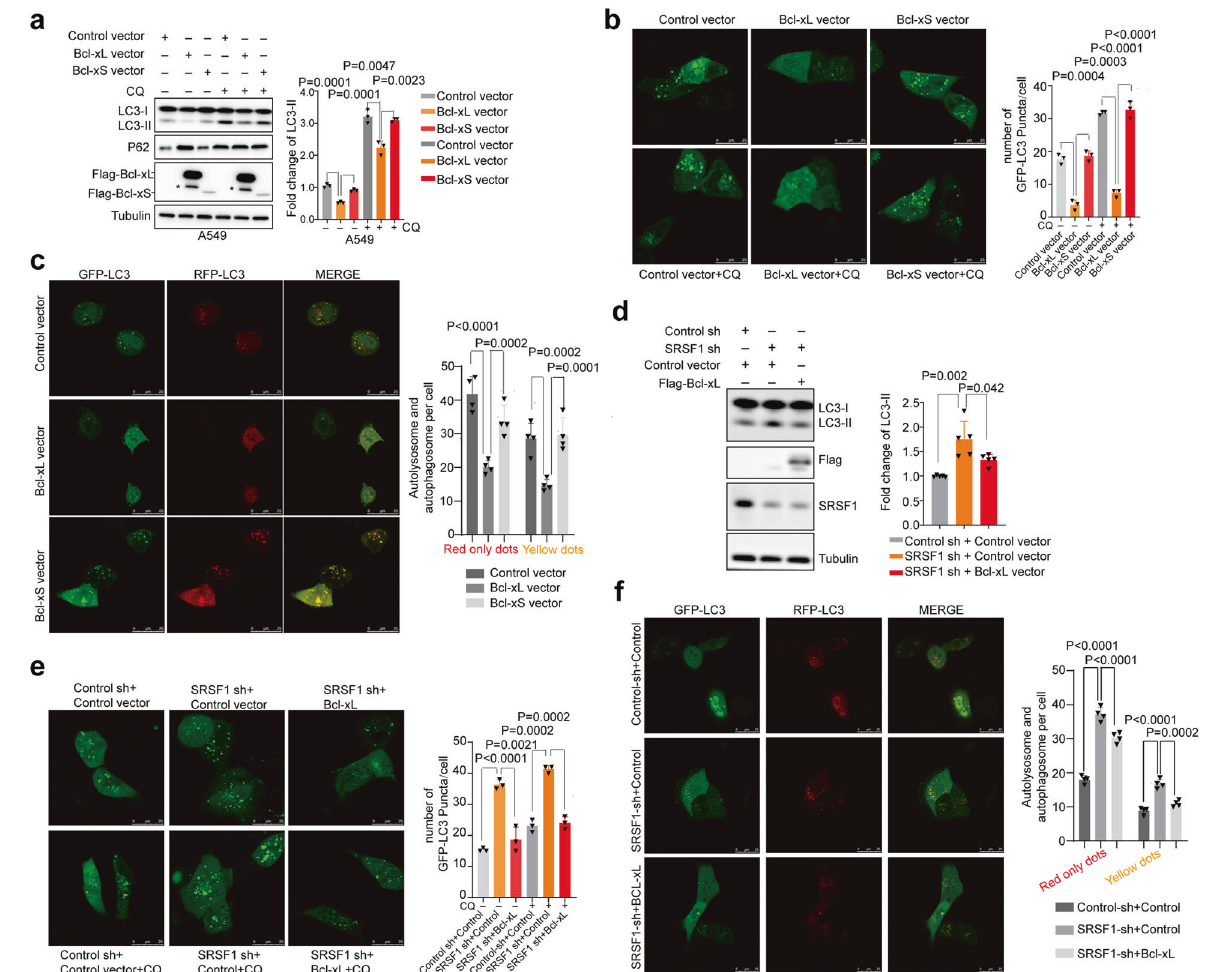
Fig. 3 Bcl-x isoforms differentially regulate autophagy. a The protein levels of LC3 and p62 were determined in A549 cells with stable overexpression of Flag-Bcl-xL, Flag-Bcl-xS, or control vector. The resulting cells were treated without or with CQ (40 µM for 2 h) respectively. The densities of signals were measured by densitometry and three experiments were performed with mean ± SD of relative fold change of LC3-II plotted. Asterisk indicated nonspeci fi c bands. b A549 cells with stable overexpression of Bcl-xL, Bcl-xS, or control vector were transfected with GFP-LC3 respectively. Twenty-four hours after transfection, cells were treated with or without CQ. Three experiments were carried out and the number of GFP-LC3 puncta per cell are represented with mean ± SD. c A549 cells with stably overexpressed Bcl-xL, Bcl-xS, or control vector were transfected with GFP-mRFP-LC3 to examine the expression of GFP and RFP by confocal microscope. Four experiments were carried out with mean ± SD of the number of autophagosomes (yellow dots) and autolysosomes (red-only dots) per cell plotted. d A549 cells with stable decrease of SRSF1 or control were transiently transfected with Flag-Bcl-xL or control vector. The protein levels of LC3 and SRSF1 were examined in a western blot assay. The densities of signals were analyzed by densitometry and fi ve experiments were carried out with mean ± SD of relative fold change of LC3-II plotted. e A549 cells with stable decrease of SRSF1 or control were transiently transfected with Flag-Bcl-xL or control vector and GFP-LC3. Twenty-four hours after transfection, cells were treated with or without CQ. Three experiments were performed and the number of GFP-LC3 puncta per cell are represented with mean ± SD. f A549 cells with stable reduction of SRSF1 or control were transiently transfected with Flag-Bcl-xL or control vector and GFP-mRFP-LC3 to examine the expression of GFP and RFP by confocal microscope. Four experiments were carried out with mean ± SD of the number of autophagosomes (yellow dots) and autolysosomes (red-only dots) per cell plotted. The p values were calculated by t -test in all panels (Fig. 6f), indicating that SRSF1 might be degraded by starvation- induced autophagy. In addition to nutrient starvation, autophagy can also be induced with other oxidative stresses, 44,45 we therefore treated cells with hydrogen peroxide (H 2 O 2 ) or sodium arsenite, and veri fi ed that the level of SRSF1 was dramatically decreased in such oxidative stresses-induced autophagy as well (Supplementary Fig. 6d). To further prove that SRSF1 is degraded through autophagy, we depleted ATG5, a factor required for autophagic vesicle formation, and also found knockdown of ATG5 could inhibit the starvation-induced reduction of SRSF1, suggesting that induction of autophagy itself leads to decreased SRSF1 protein (Fig. 6g, Supplementary Fig. 6e). Signal Transduction and Targeted Therapy (2021)